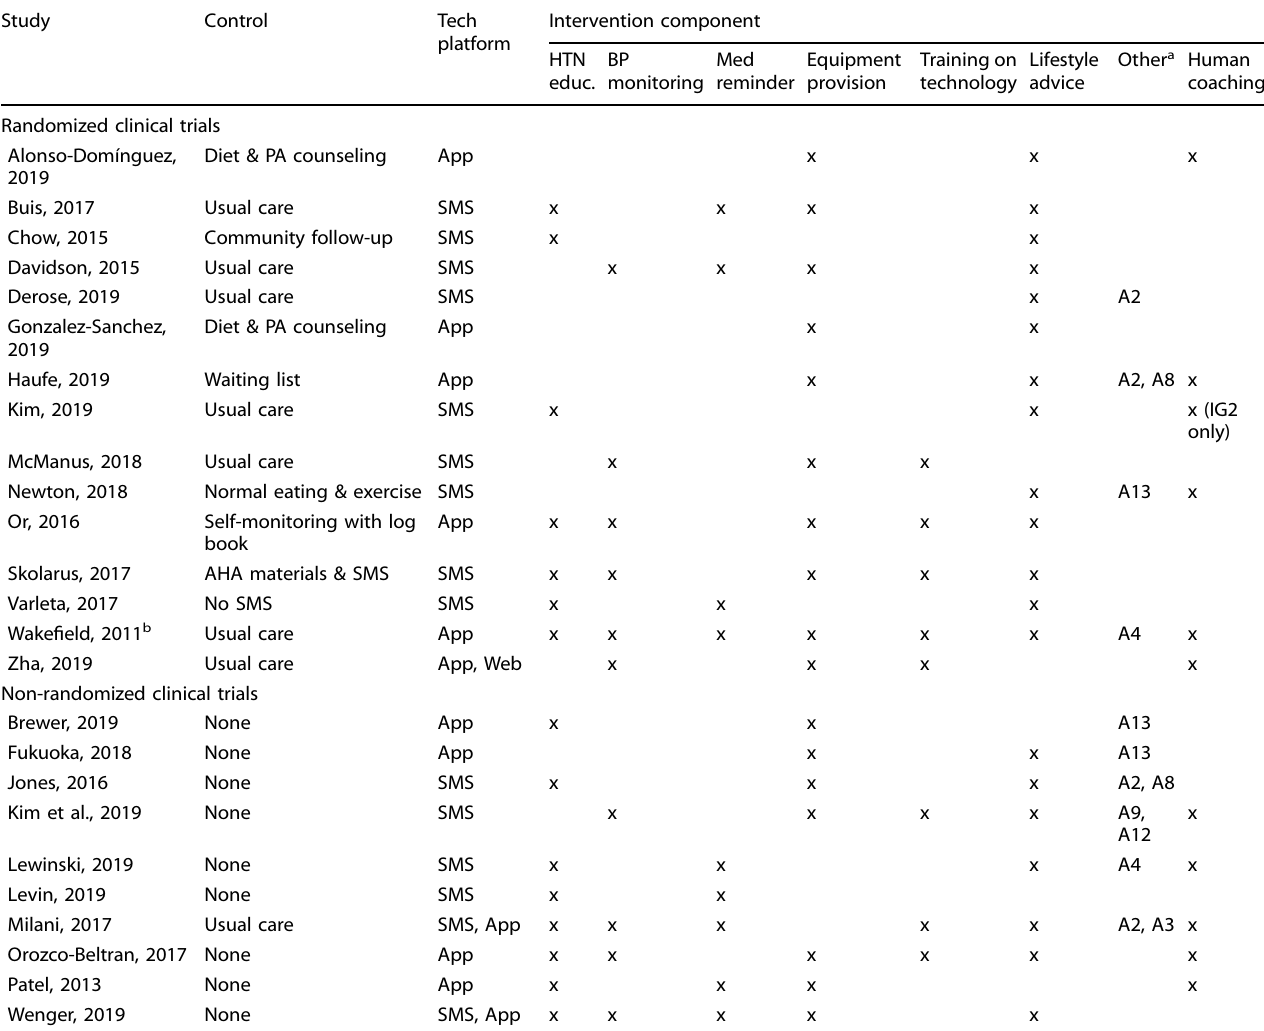
Abbreviations: SMS (short message service), also known as text messaging. a Refers to other PRISMS components: A2. Information about resources; A3. Provision of/agreement on speci fi c action plans; A4. Regular clinic review;